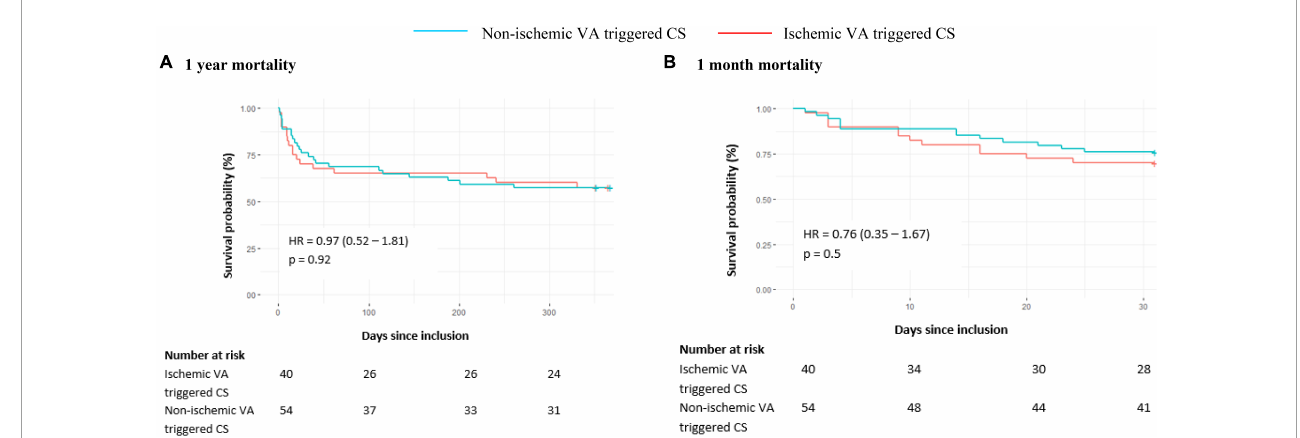
FIGURE2 All-cause mortality in the VA group according to associated ischemic cardiomyopathy at 1 year (A) and 1 month (B) . The cumulative incidences of 1-year and 1-month mortality were estimated with the use of the Kaplan–Meier method; hazard ratios and 95% confidence intervals were estimated with the use of Cox regression models. Underlying cardiopathy was considered ischemic in the presence of at least one culprit lesion hemodynamically significant on coronary angiography (stenosis or thrombosis). CS, cardiogenic shock; HR, hazard ratio; VA, ventricular